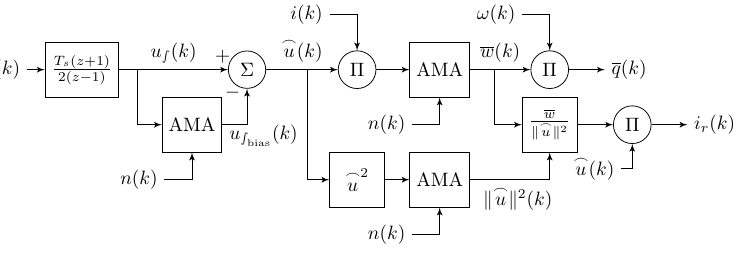
Figure 4. Block diagram representation of the CPT’s reactive measurements in the discrete time